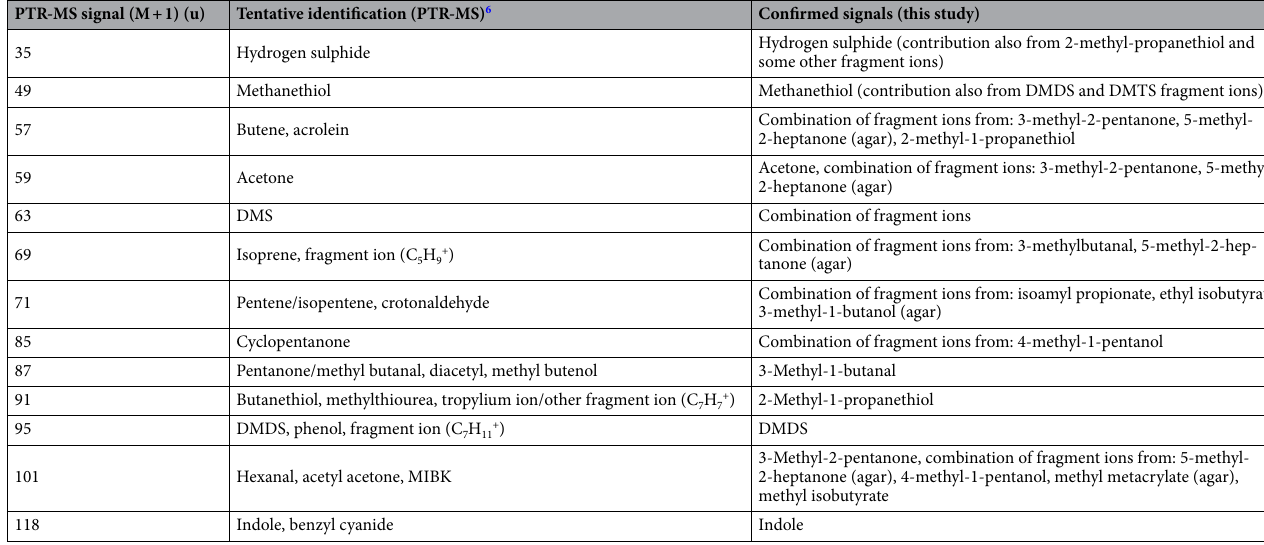
Table 2. Comparison of previously tentatively identified PTR-MS signals 6 to the results obtained in this study using GC–MS and the fragmentation pattern analysis of the PTR-MS signals.